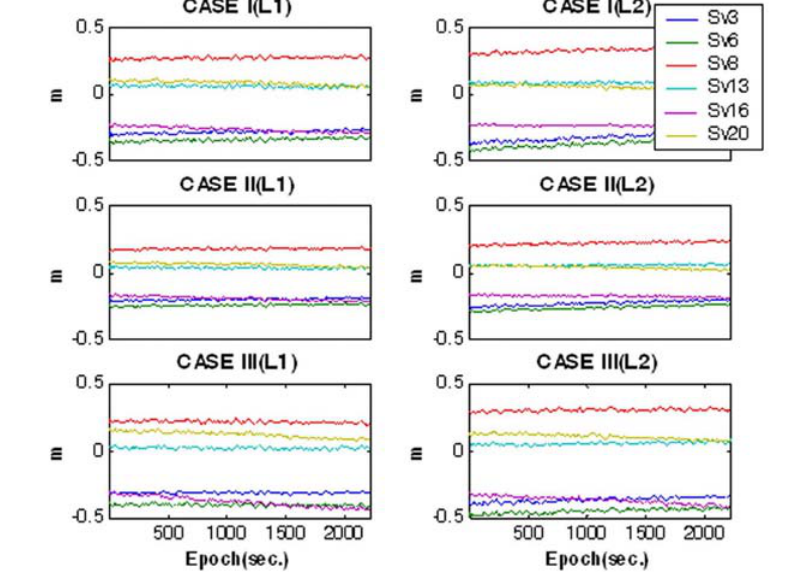
Figure 7. Interpolated GPS baseline-dependent errors (network corrections).